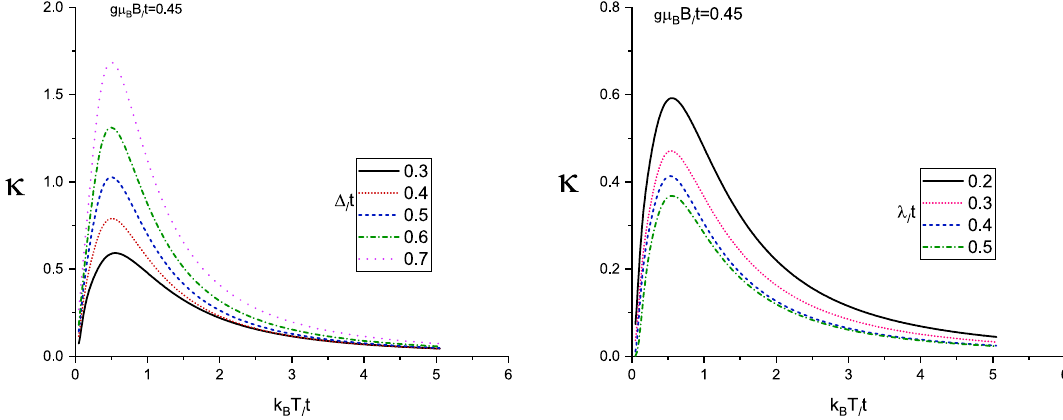
Figure 5. Left Panel: Thermal conductivity of Lieb lattice as a function of normalized temperature k B T / t for different values of normalized gap parameter �/ t in the presence of magnetic field g µ B B / t = 0.45 . Normalized chemical potential and normalized spin-orbit coupling have been fixed at µ/ t = 1.0 and (cid:31) / t = 0.2 , respectively. Right Panel: Thermal conductivity of Lieb lattice as a function of normalized temperature k B T / t for different values of normalized spin-orbit coupling (cid:31) / t in the presence of magnetic field g µ B B / t = 0.45 . Normalized chemical potential and normalized gap parameter have been fixed at µ/ t = 1.0 and �/ t = 0.3 ,